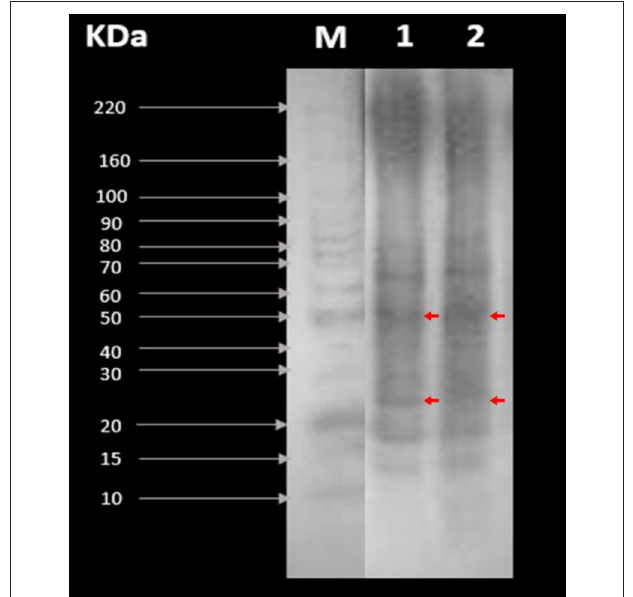
FIGURE 2 | SDS-PAGE patterns of (1) raw protein concentrate (RPC) and (2) cooked protein concentrate CPC. M is the molecular weight marker (control).